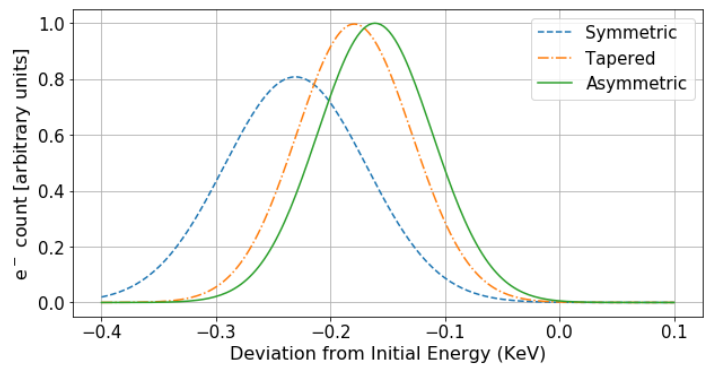
Figure 13. Energy preservation in three different kinds of einzel lenses. It is clear on the graph that the two asymmetrical designs result in less energy loss compared with the standard